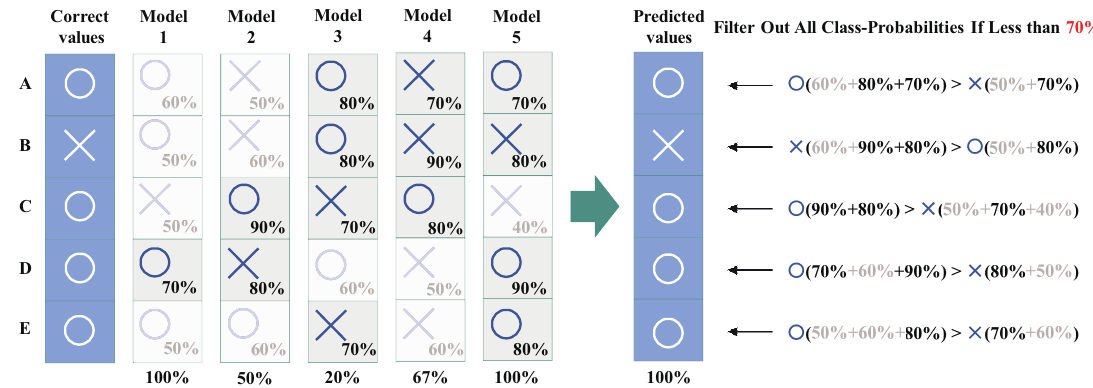
Figure 5. Example of range voting using all class probabilities that scored above 70% based on Figure